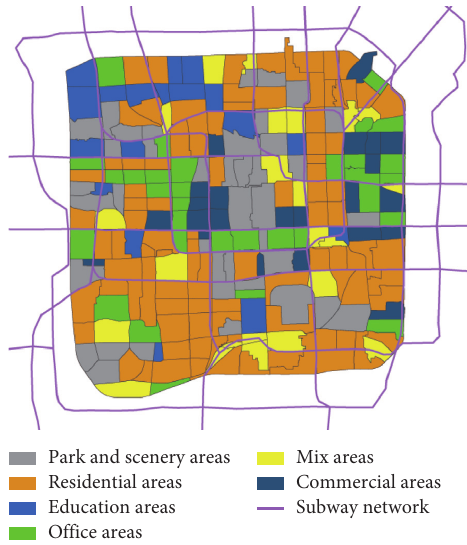
Figure 5: Result of identification.